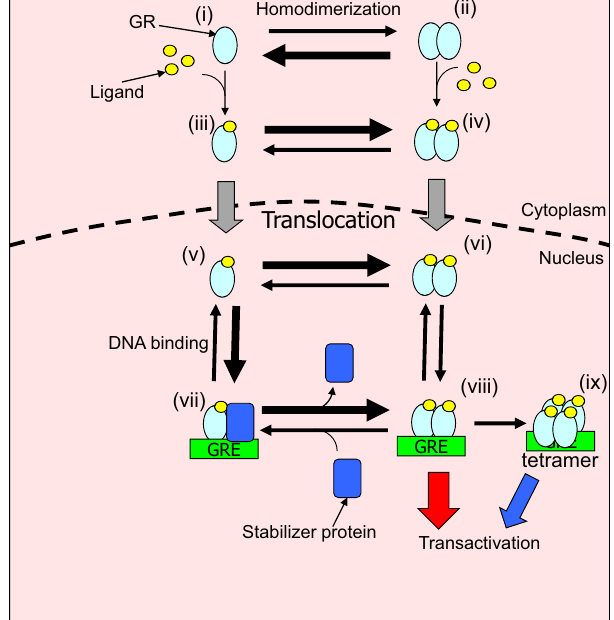
Figure 6. Schematic drawing of processes from GR homodimerization and transactivation. In the absence of ligand, GR in the cytoplasm forms a heterocomplex with chaperones, FKBP51, and other proteins (not shown in this figure). GR is homodimerized at a basal level ((i) ↔ (ii)). Upon ligand binding, GR tends to form homodimer during nuclear translocation ((iii) ↔ (iv)). After nuclear translocation ((iii) → (v), (iv) → (vi)), GR is able to homodimerize independently on the GRE ((v) ↔ (vi)). Monomer which may complex with stabilizer proteins binds strongly to GRE ((v) ↔ (vii)). Triggers such as exchange factors for stabilizer proteins, other monomers, and coactivators may convert stable monomer binding to homodimeric states on the DNA ((vii) ↔ (viii)). Transcriptional activity is altered based on the amount of homodimer, due to the increasing homodimer DNA binding fraction (red arrow). If the amount of GR homodimer increases, GR tetramerization, which prior research has shown 19,20 , takes place on the GRE ((viii) → (ix)) and may also be involved in modulating transcriptional activity (blue